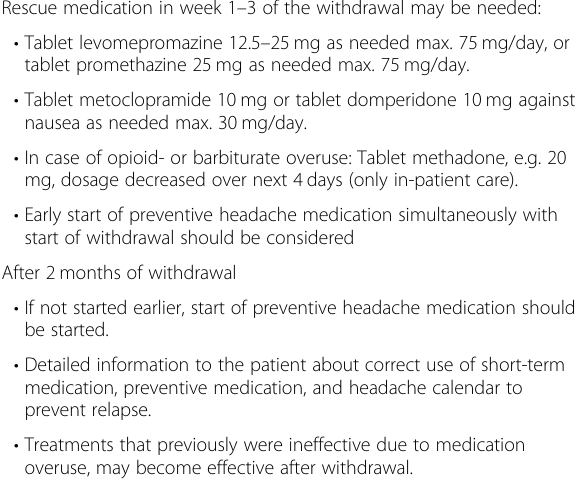
Table 18 Pharmacological treatment for medication overuse